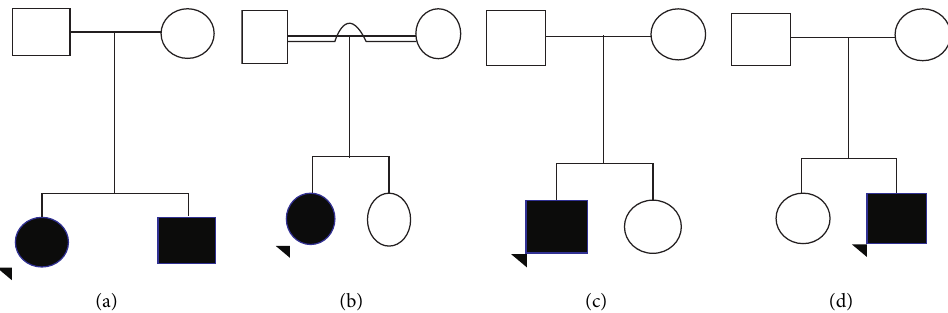
Figure 1: Pedigrees of the patients diagnosed with AT following whole-exome